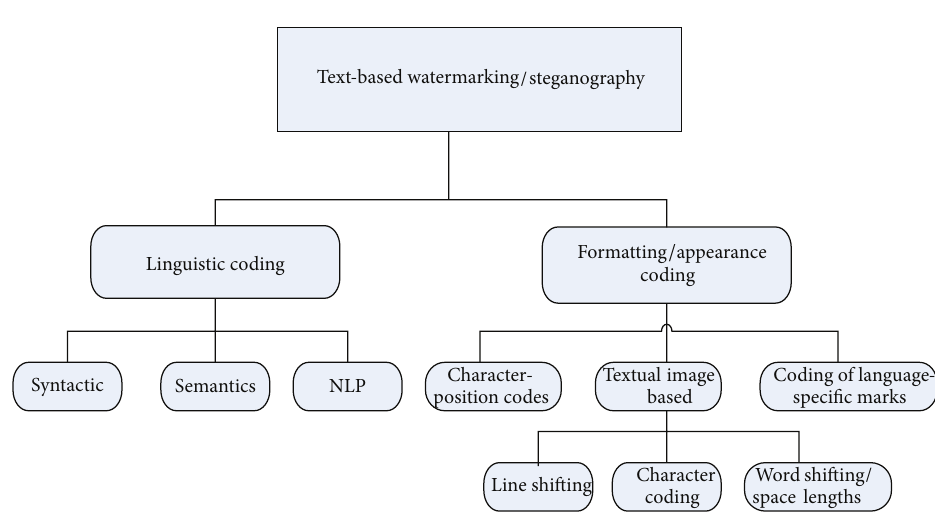
Figure 3: Digital-watermarking